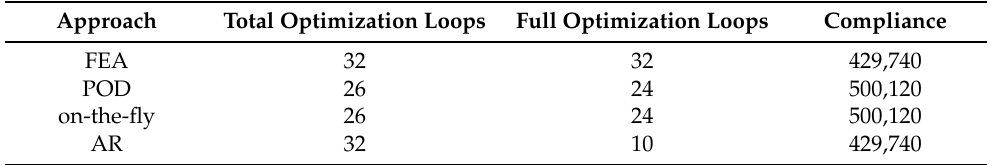
Table 2. 3D wheel: Results of each MOR approach as well as the classic